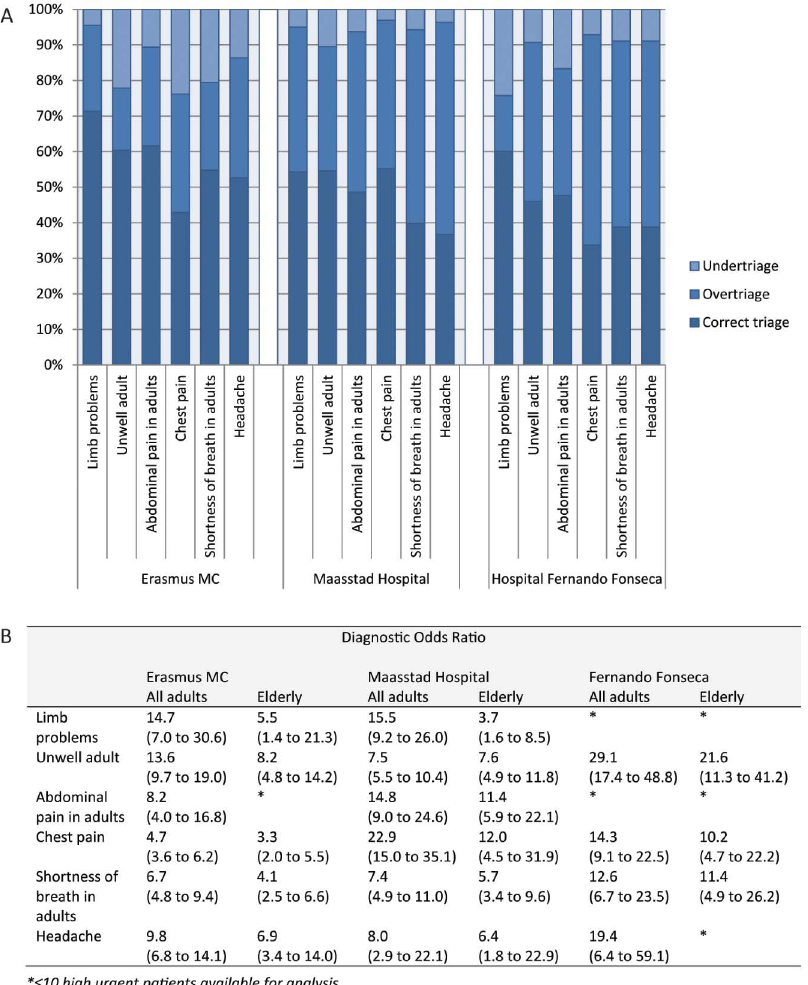
Fig 2. Performance of most commonly used MTS flowcharts. A) Percentagesunder-, over-, and correct triage; B) Diagnosticodds